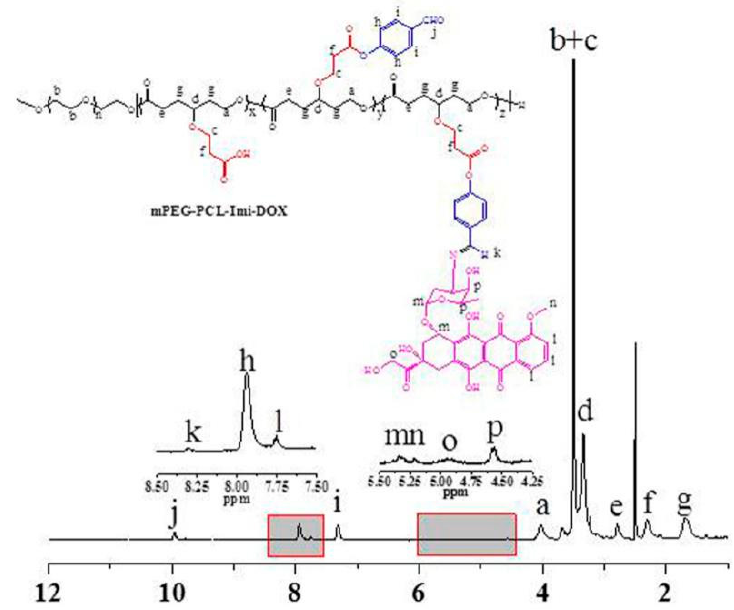
Figure 3. 1 H NMR spectrum of